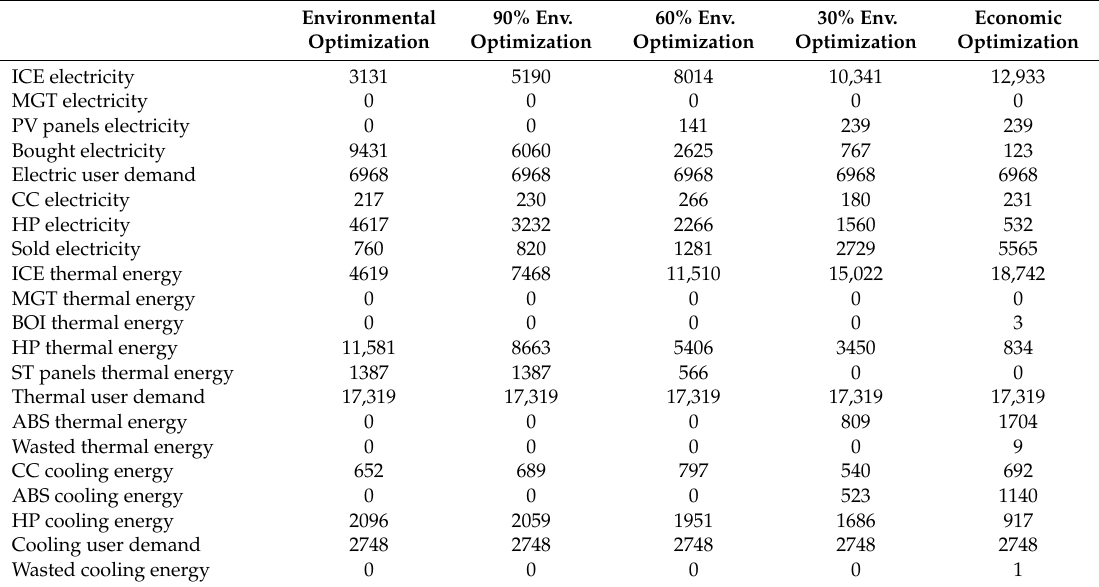
Table 11. Total optimal annual energy magnitudes (MWh)—distributed generation